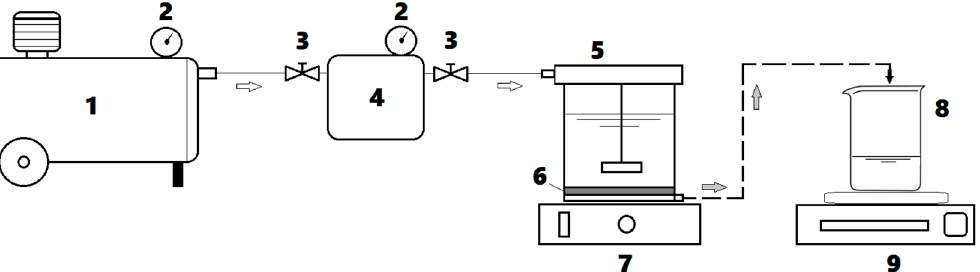
Figure 1. Dead-end ultrafiltration (UF) system employed for experimentation: ( 1 ) air compressor; ( 2 ) manometers; ( 3 ) pressure control valves; ( 4 ) dispensing pressure vessel; ( 5 ) UF stirred cell; ( 6 ) porous membrane; ( 7 ) magnetic stirrer; ( 8 ) permeate container; ( 9 ) digital balance.